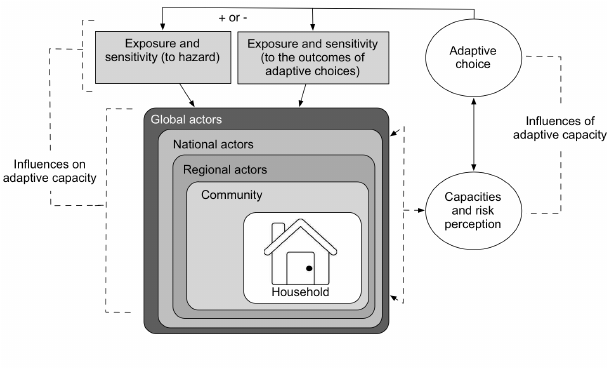
Fig. 1. The household as an element of the governance